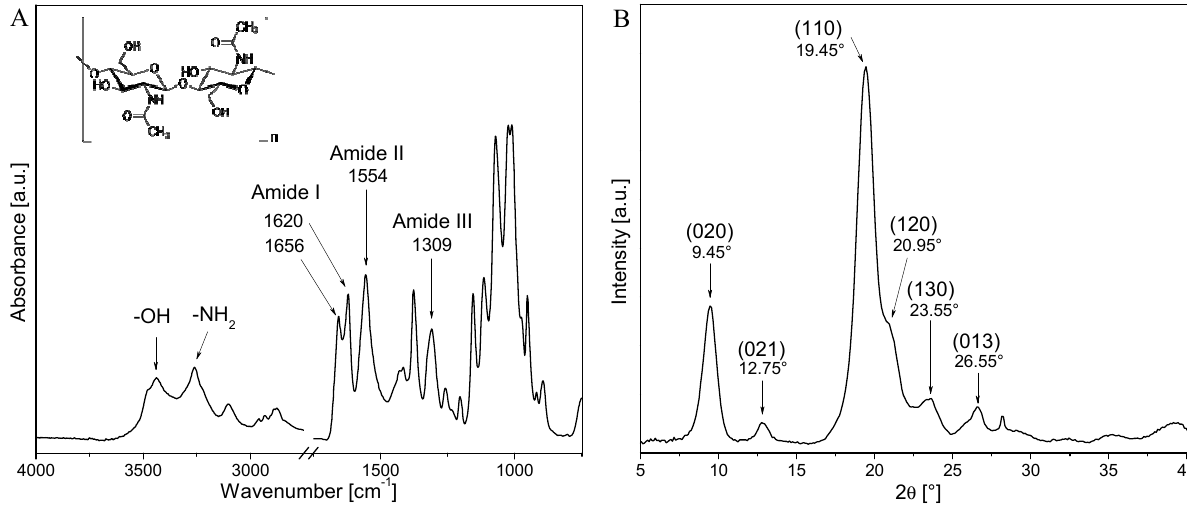
Figure 2. ( A ) FTIR spectrum and ( B ) WAXS patterns of dry powdered chitin nanoparticles.